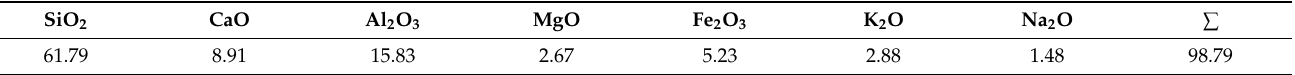
Table 2. Chemical composition of soil (wt.%).